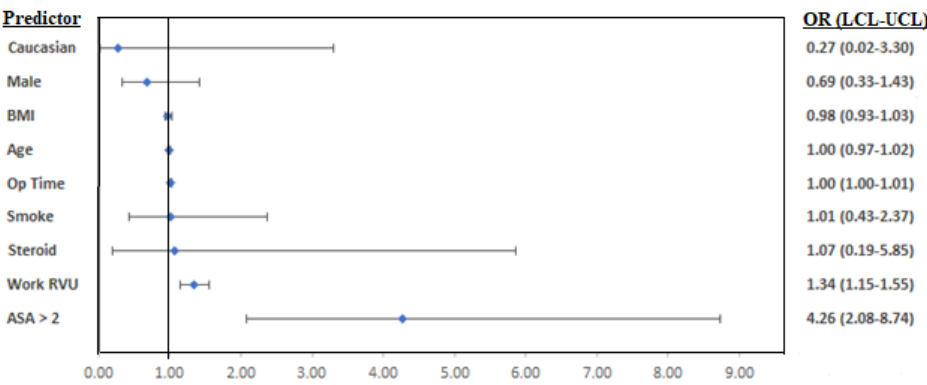
Figure 4. A forest plot visualization of the multivariable regression results. Lab values were removed from the forest plots